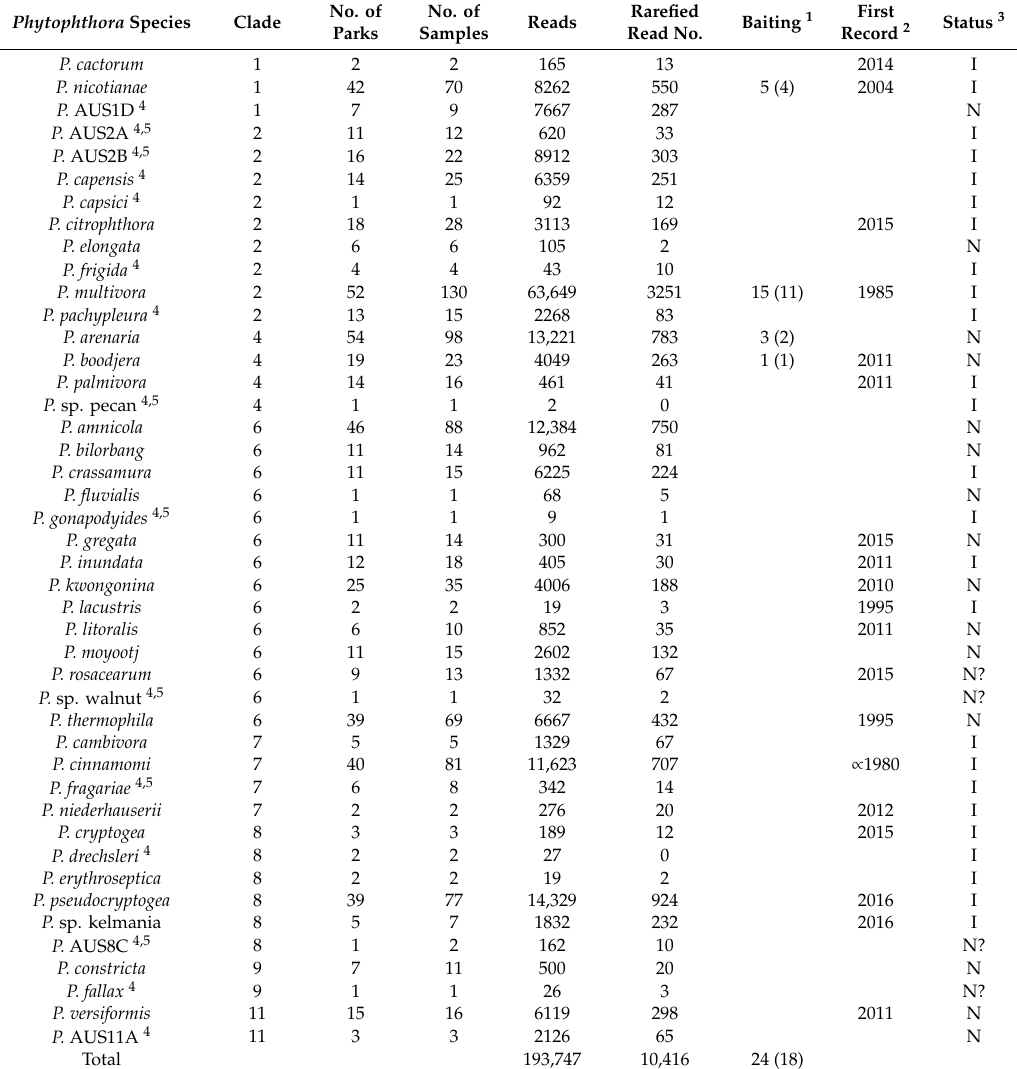
Table 2. Phytophthora species ( n = 44) detected by metabarcoding from the urban forest in the City of Joondalup, Western